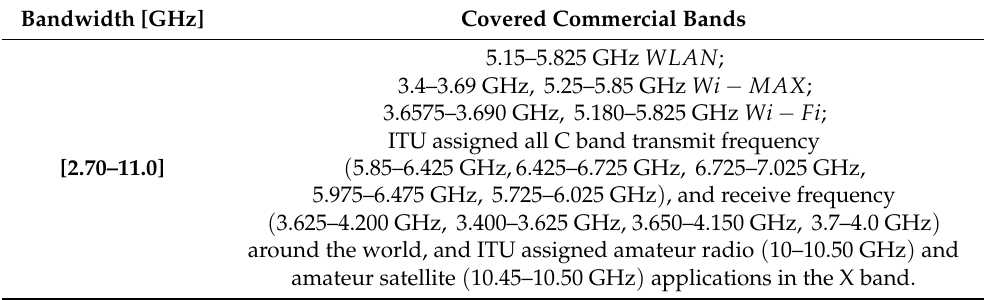
Table 2. Frequency bands that the suggested antenna would cover.